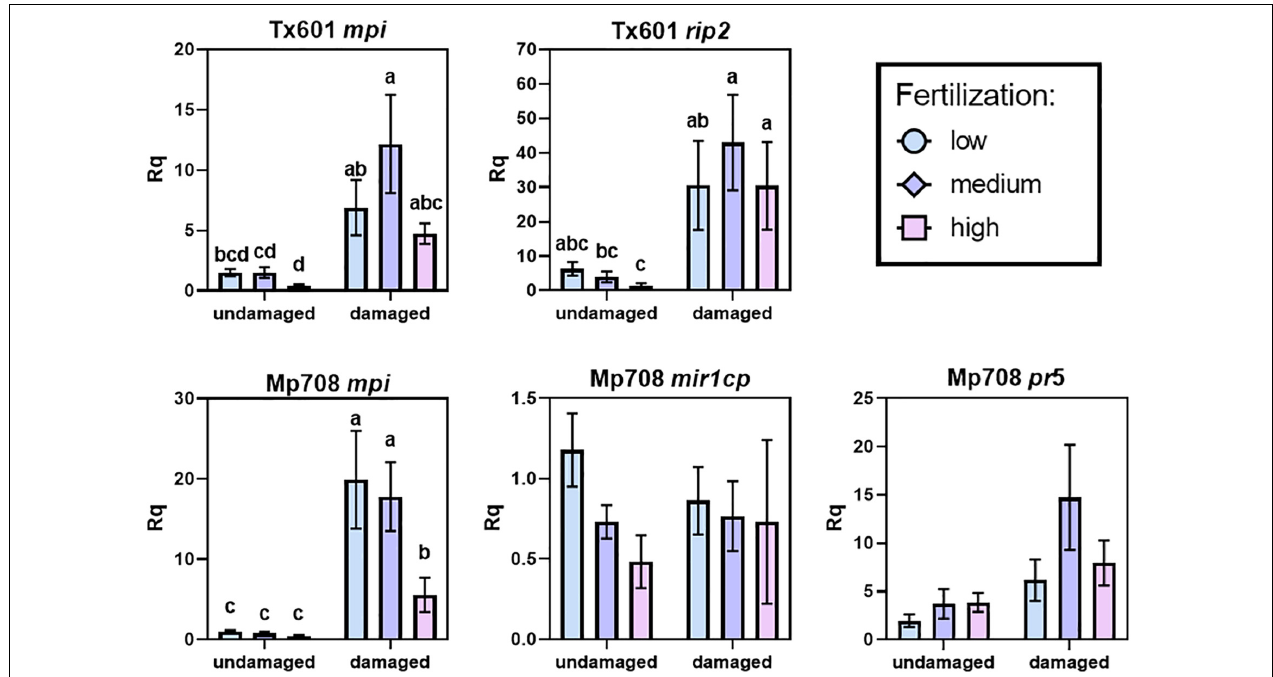
FIGURE 2 | Influence of herbivory and fertilization on the expression of defense-related genes in Tx601 and Mp708. Letters represent statistically significant pairwise comparisons within a transcript. Statistical analyses were conducted using log 10 ( y ) transformed responses. Full statistics are presented in Table 3 . rip2 – ribosome inactivating protein 2; mpi – maize protease inhibitor; mir1cp – Mir1 cysteine protease; pr5 – pathogen response protein 5.